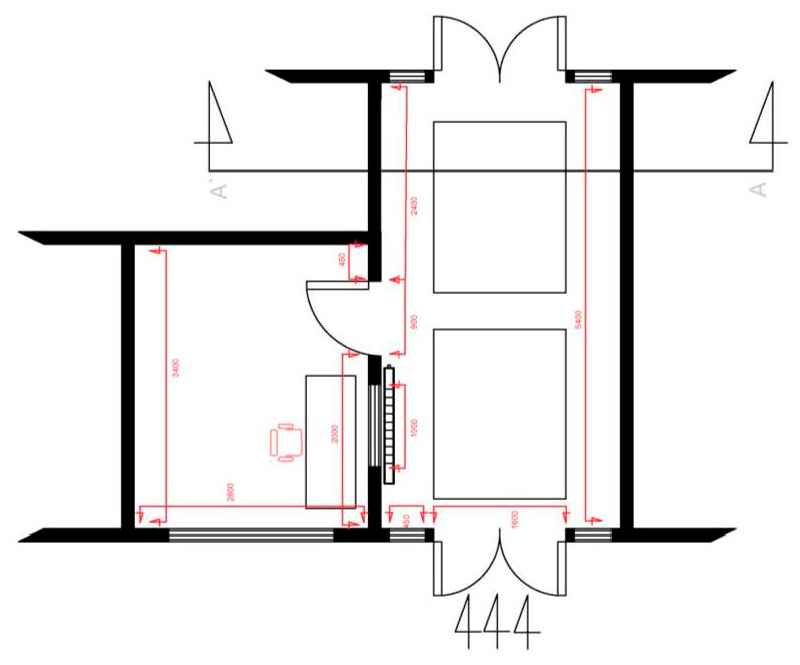
Figure 7. Floor plan of the entrance hall in PK 12-room without green